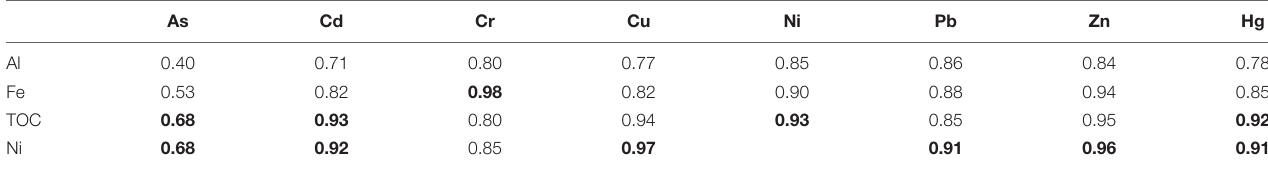
TABLE 2 | Median R 2 values for the linear regressions between contaminant concentrations (8 metals) and 4 co-factors, based on nine sampling locations (period 2008–2014). As